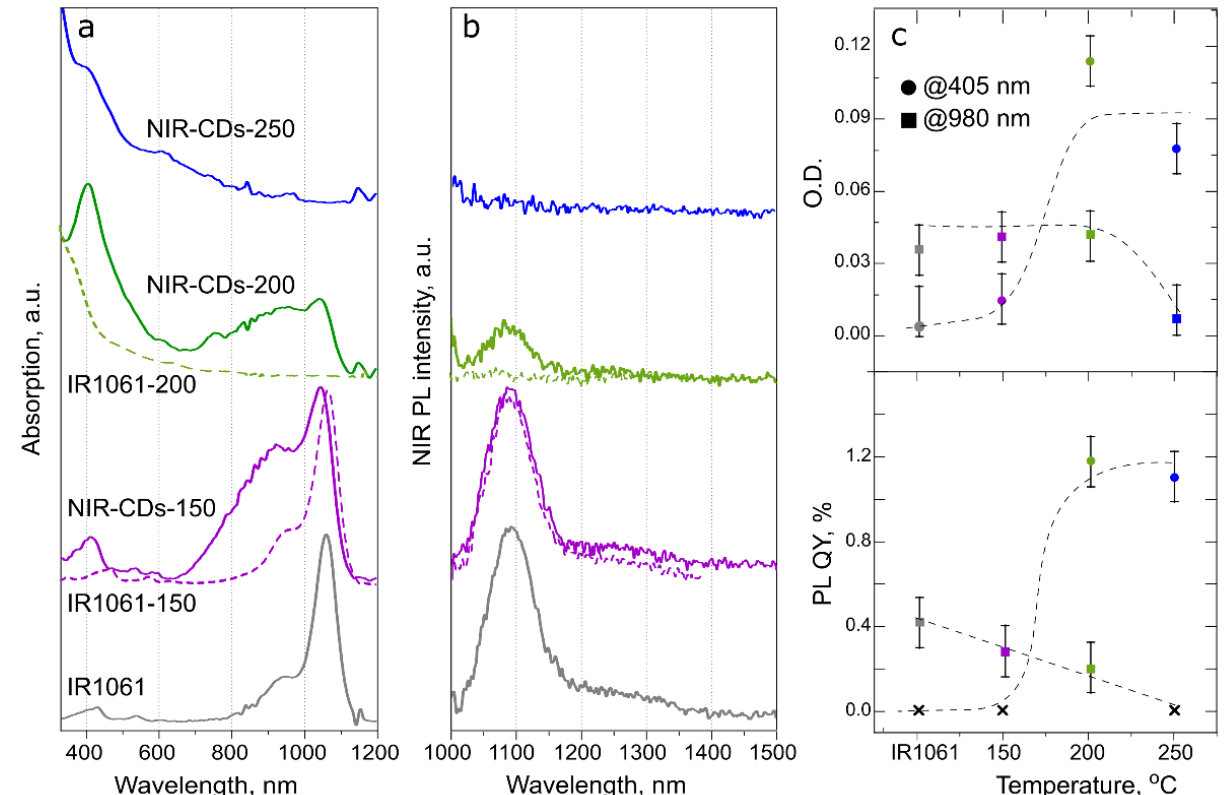
Figure 5. Optical properties of NIR-CDs and the related reference samples produced at different temperatures. ( a ) Absorption, and ( b ) PL spectra (excited at 980 nm) of the organic dye IR1061 (grey), NIR-CD-150 (magenta), NIR-CD-200 (green), and NIR-CD-250 (blue), compared with reference samples IR1061-150 (dashed magenta line) and IR1061-200 (dashed green line). ( c ) Optical density (upper panel) and PL quantum yield (QY, lower panel) of the NIR-CDs versus annealing temperature, excited at 405 nm (circles) and 980 nm (squares). Black crosses demonstrate the absence of any PL signal; error bars represent the instrument/estimation error.